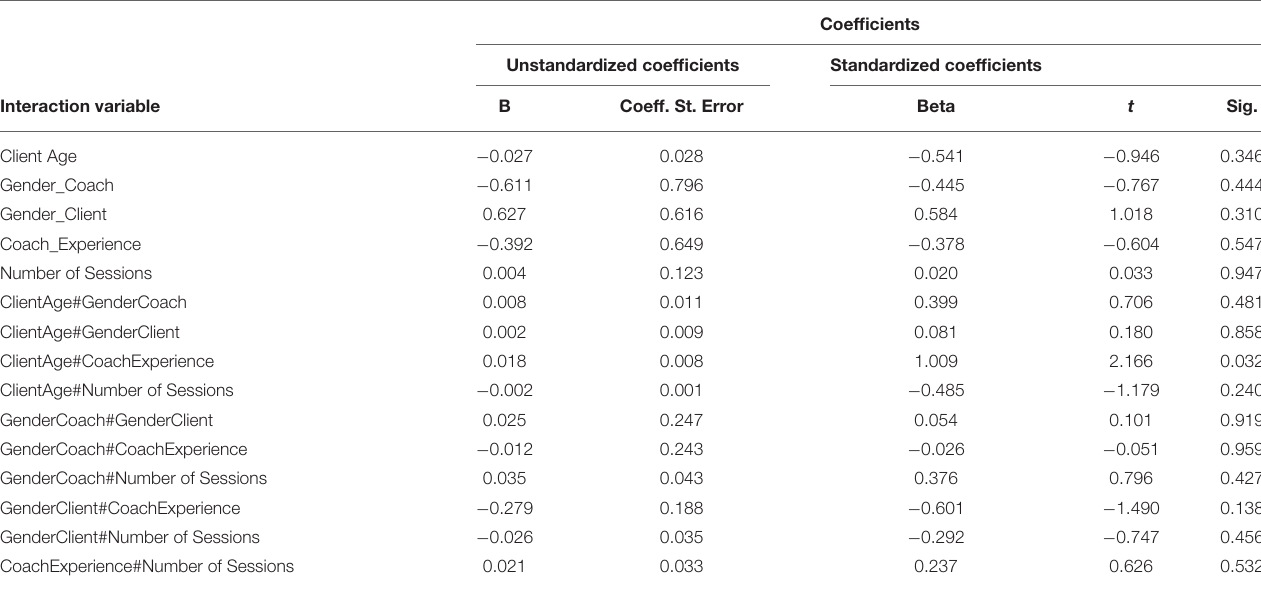
TABLE 5a | Linear curve type